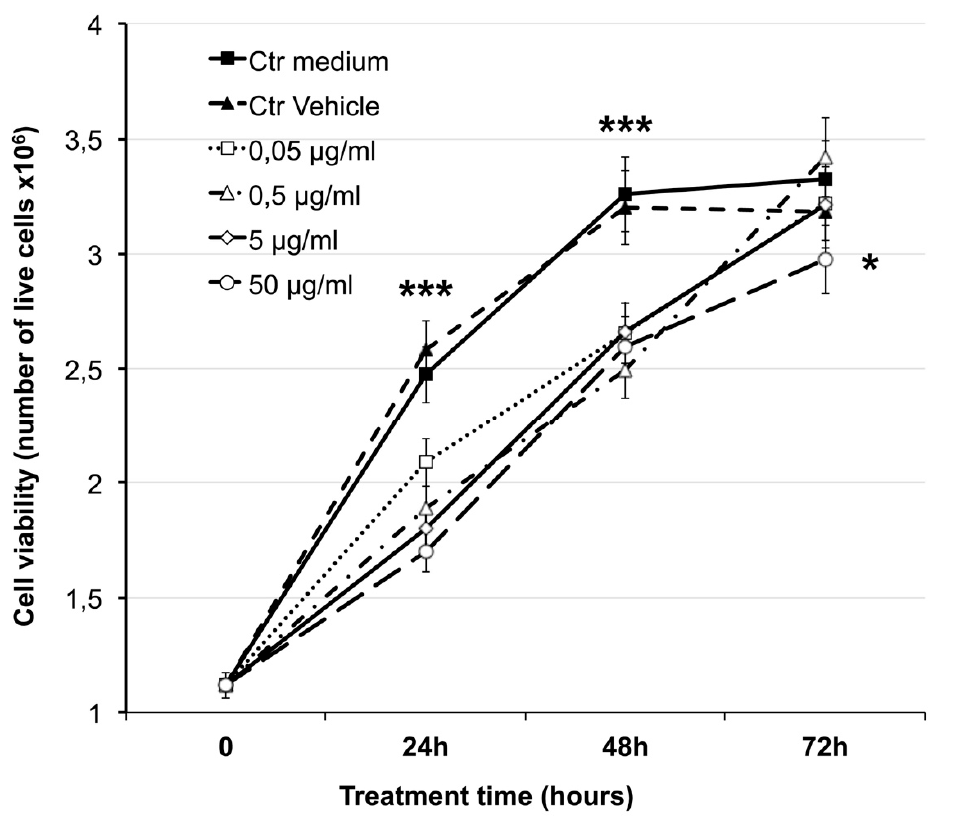
Figure 1. Time course and dose-dependent e ff ect of GSE on MCF-7 cell viability. Concentration is expressed as µ g of gallic acid equivalent (GAE) / mL of medium. Data are mean ± SD of three independent experiments in quadruplicate (* p ≤ 0.05, *** p ≤ 0.01).